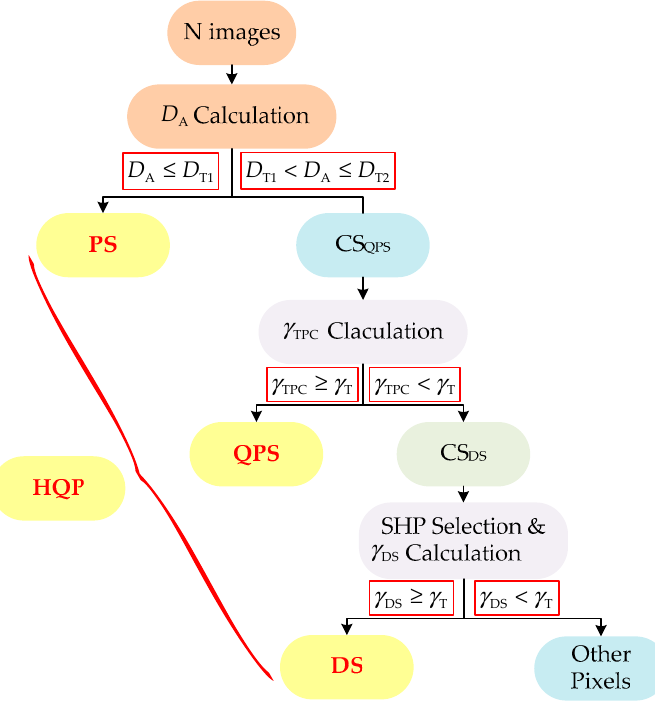
Figure 6. Processing flow for the high-quality pixel (HQP) selection.